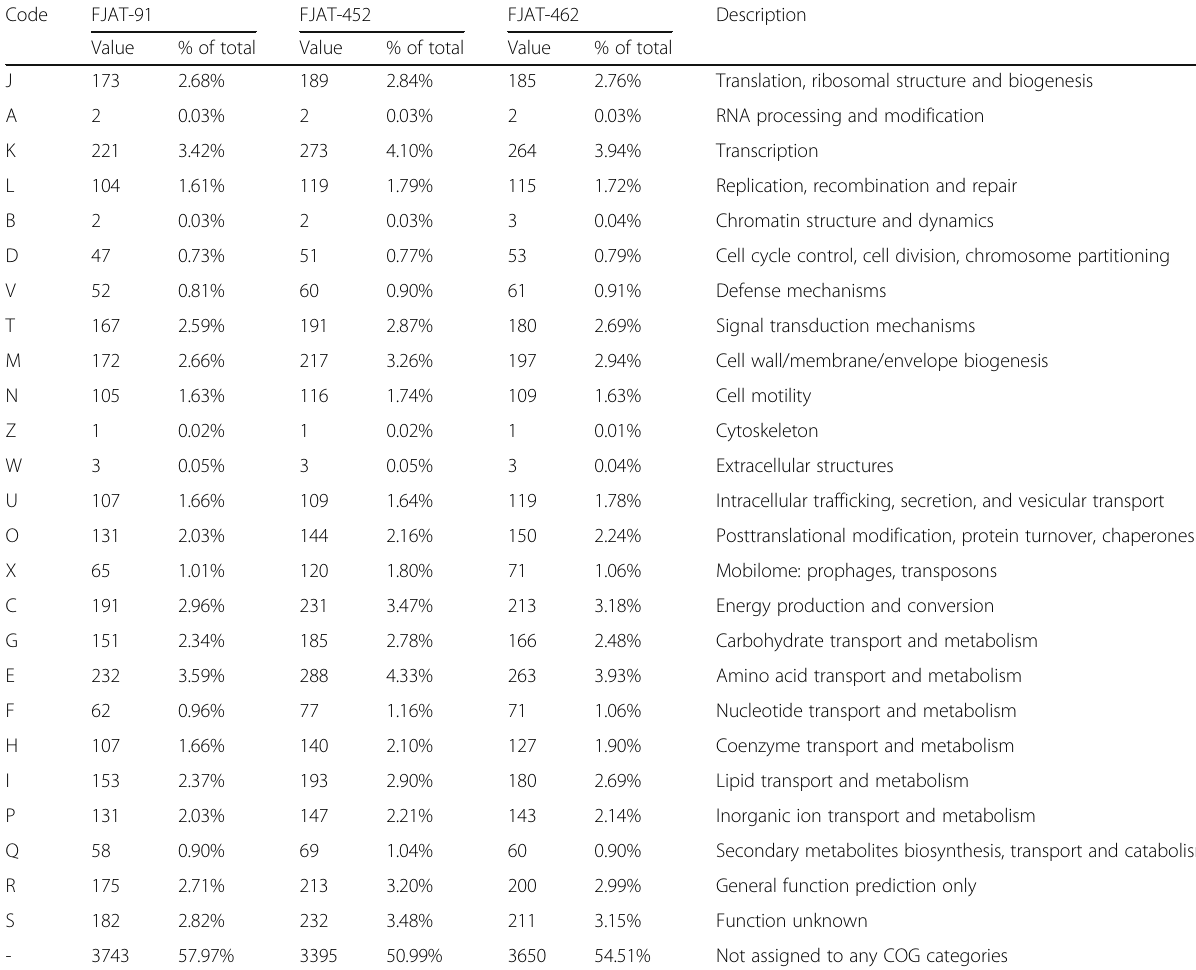
Table 6 Number of genes that are associated with different COG functional categories Code